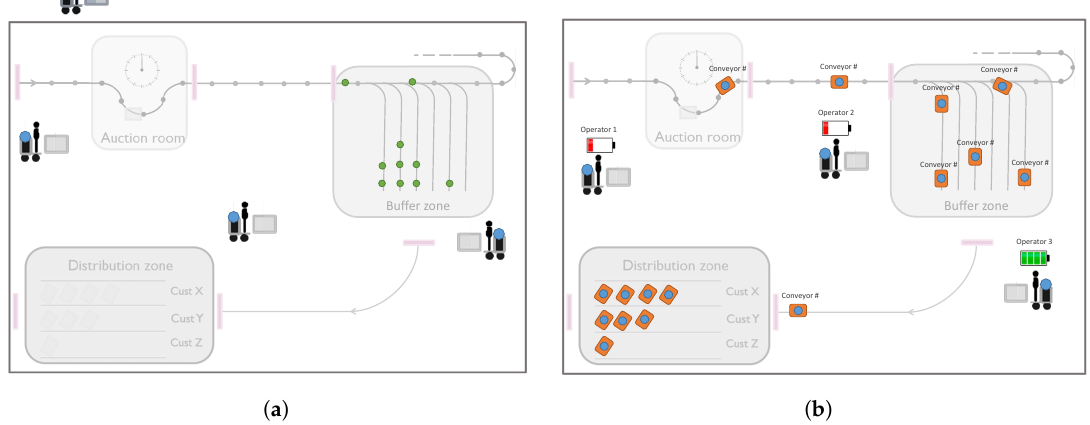
Figure 13. ( a ) The localization after translation and mapping; ( b ) Sample application for the combination of position data with LwM2M semantic